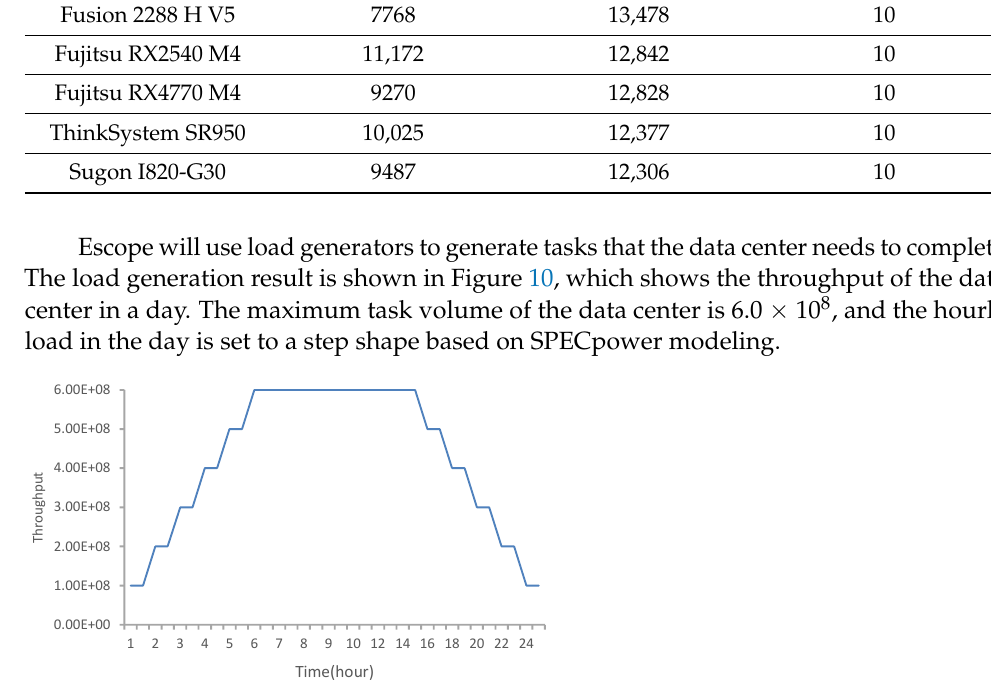
Table 5. Simulation results of data center #5.